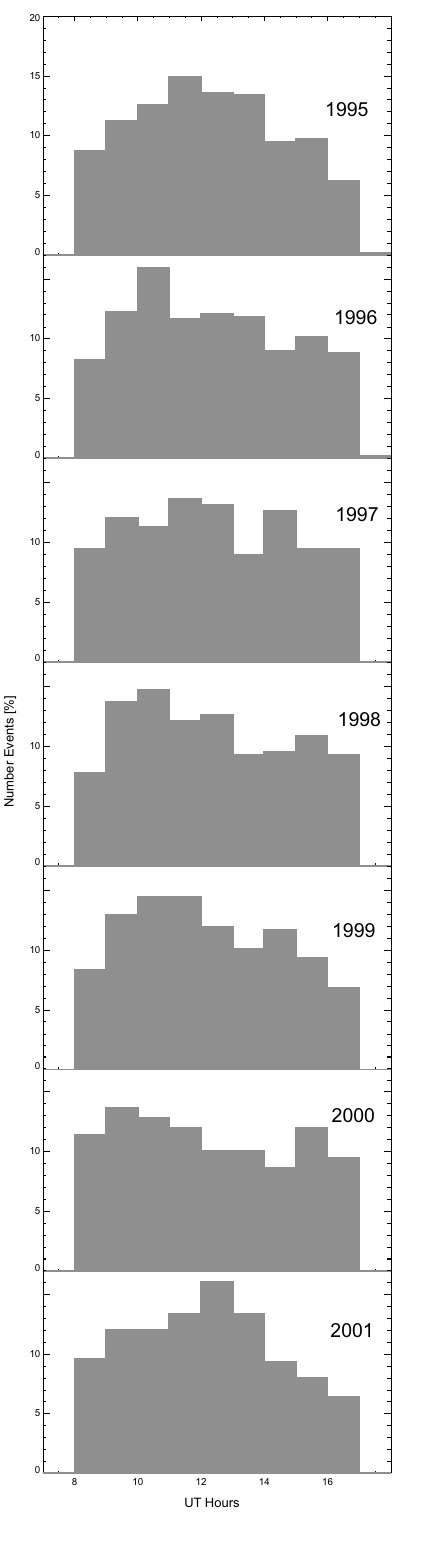
Fig. 5. Relative occurrences, as functions of the universal time of events, displayed individually for each year as shown in the panels. The format of the gray block-diagrams is the same as for Fig. 4.